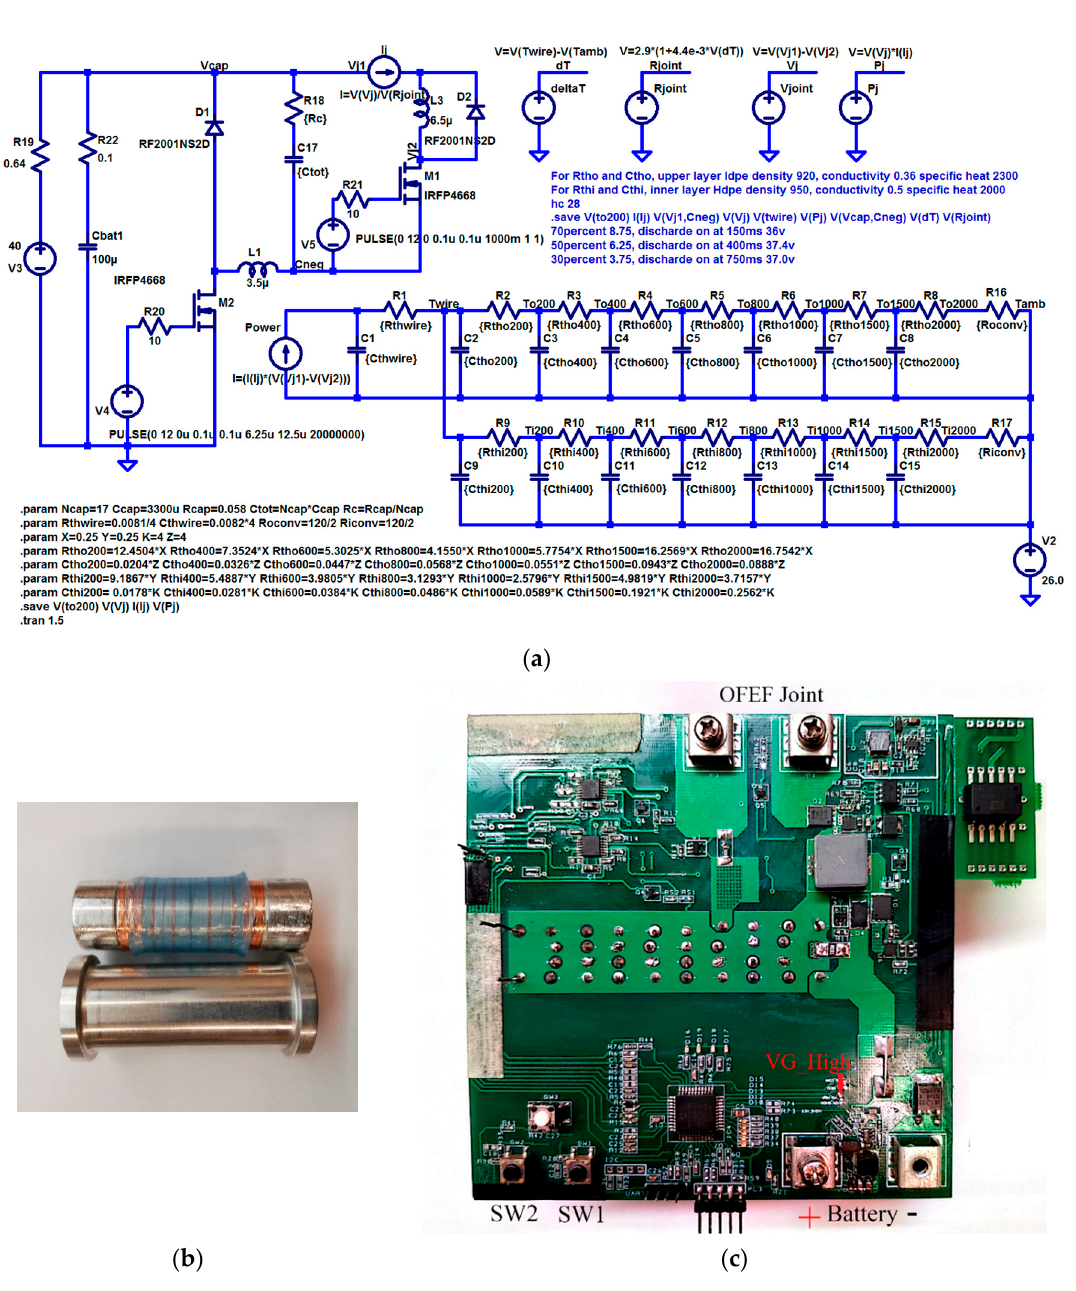
Figure 3. Previous work by Akram et al. [3]: ( a ) developed the LTspice electrothermal model; ( b ) fabricated resistive type optical fiber electrofusion joint (ROFEF) with an aluminum mold; ( c ) controller board with PWM and capacitor bank of 0.056 farads.